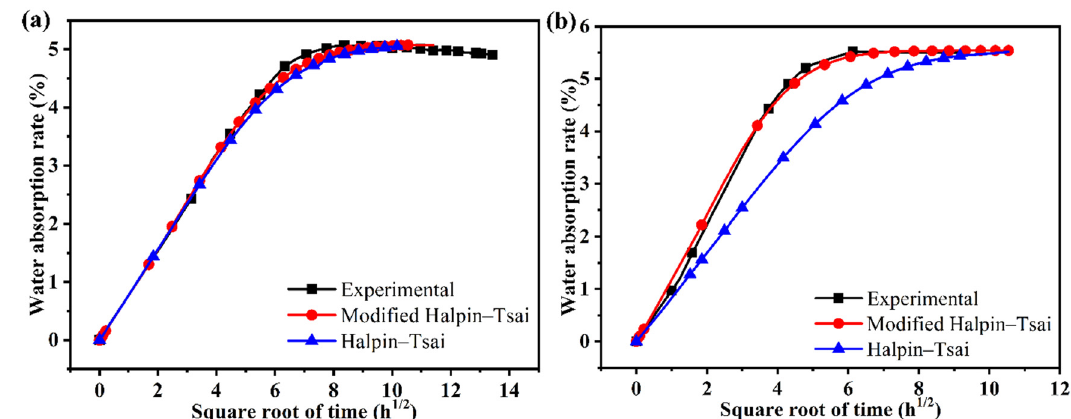
Figure 5: Moisture absorption curves of ( a ) CF/PA6 composites ( Panex ® 35 - 50K ) composites, and ( b ) CF/PA6 ( SYT49S - 12K ) composites obtained using experimental data, modi fi ed Halpin – Tsai equation, and Halpin – Tsai